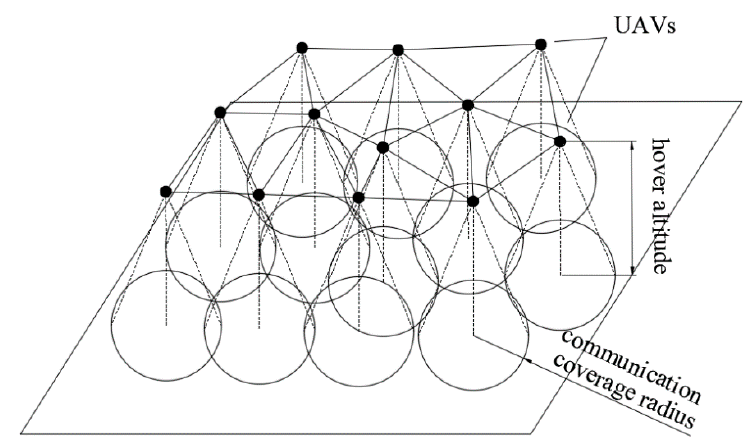
Figure 1. The system model of the communication coverage problem of the mobile wireless sensor network (MWSN). The black points represent the unmanned aerial vehicles (UAVs), and their communication coverage areas on the ground are the circles.